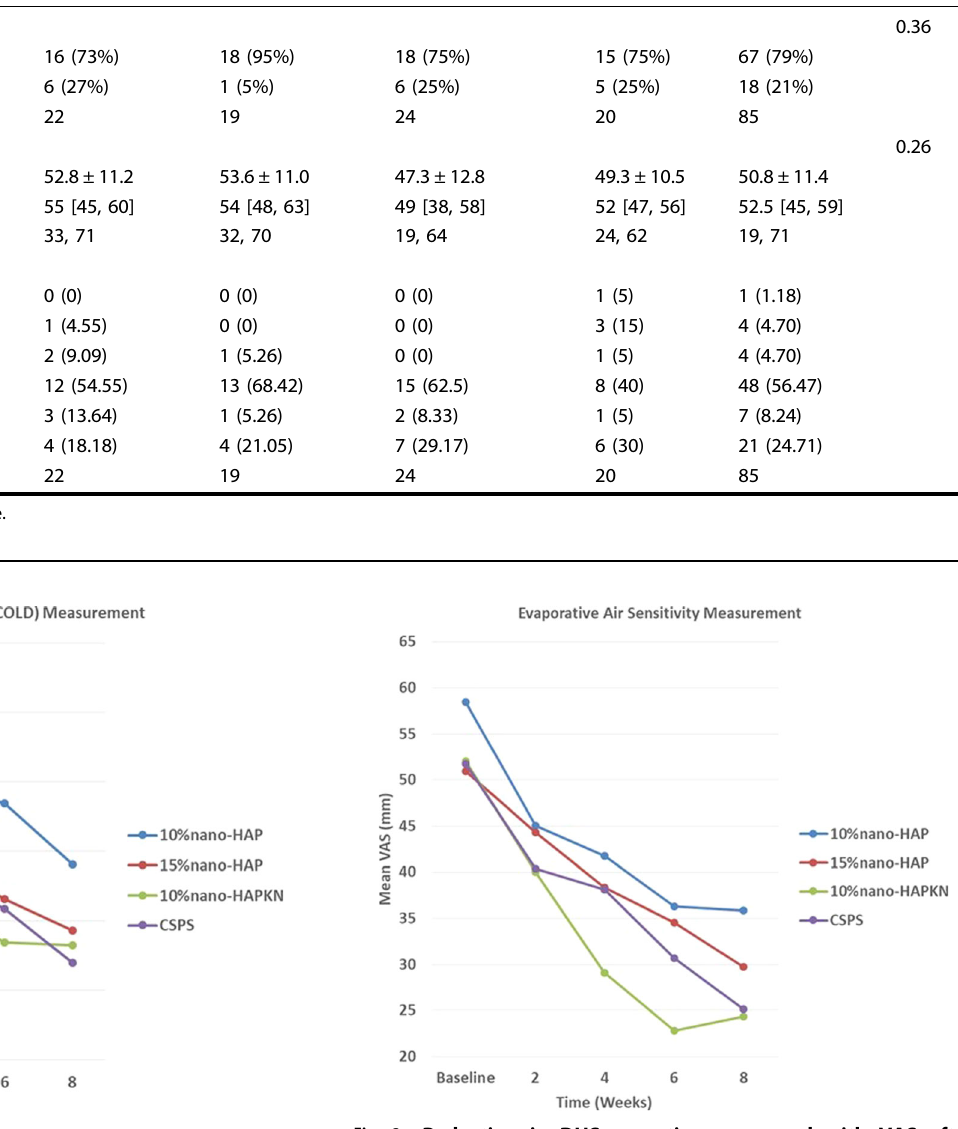
Fig. 3 Reduction in DHS over time measured with VAS after evaporative air stimulus. For each product, there was a signi fi cant ( P < 0.001) reduction in DHS at each time point. Comparing the reduction of DHS among the products, the following product pairs differed signi fi cantly ( P < 0.001) from each other at the indicated measurement time period. Week 2: no signi fi cant difference among the products. Week 4: 10%nano-HAPKN and 10%nano-HAP; week 6: 10%nano-HAPKN and 10%nano-HAP, 10%nano-HAPKN and